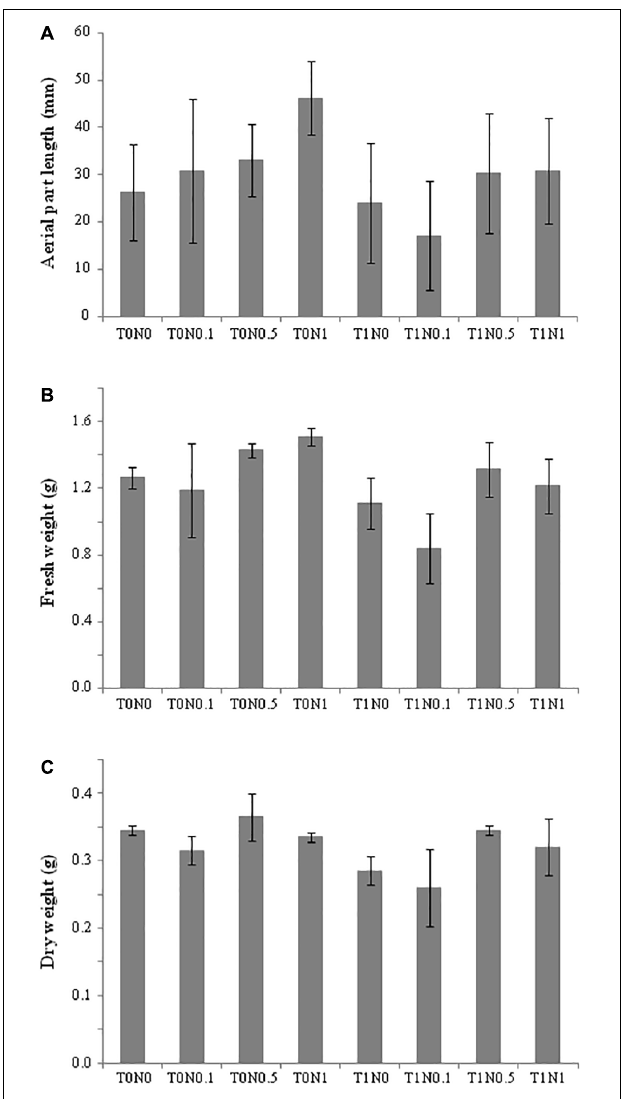
FIGURE 3 | Measurements of wheat seedlings after being growth for 48 h under eight different conditions: with (T0) or without (T1) Trichoderma harzianum T34 and 0 (N0), 0.1 (N0.1), 0.5 (N0.5) or 1 (N1) mM calcium nitrate as nitrogen source. (A) Aerial part length, (B) fresh weight, and (C) dry weight. For each measurement, mean values of 20 plants from two independent experiments are